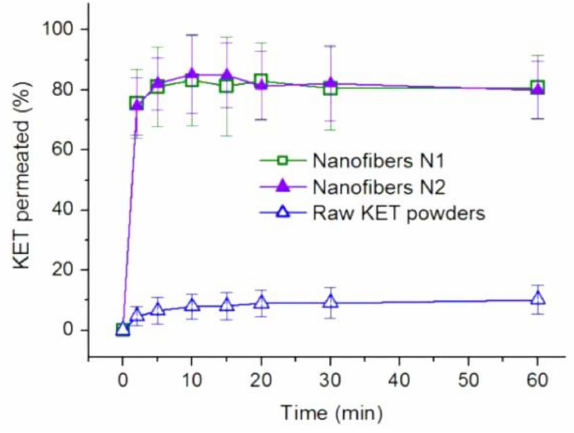
Figure 10. Ex vivo permeation tests of N1, N2, and the raw KET